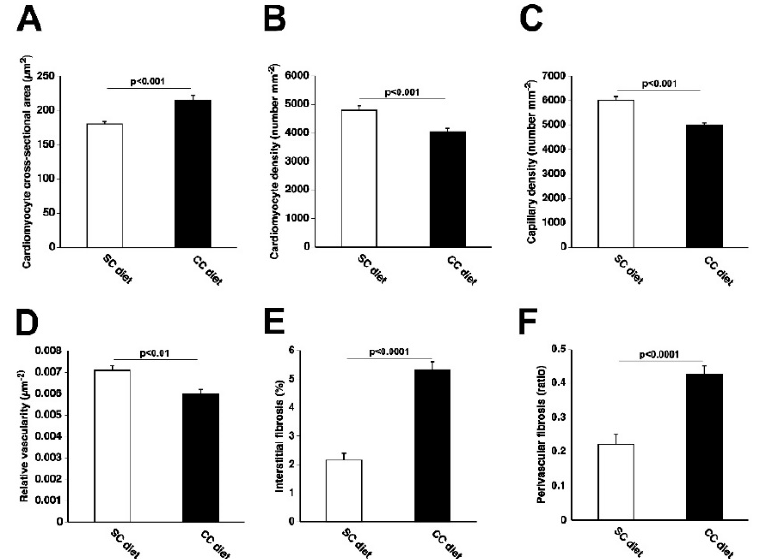
Figure 2. Body weight ( A ), glucose level ( B ), insulin ( C ), heart weight ( D ), tibia length ( E ), heart weight/tibia length ( F ), left ventricular weight ( G ), right ventricular weight ( H ), atrial weight ( I ), and lung weight ( J ) in C57BL/6 standard chow (SC) diet mice and in C57BL/6 coconut oil (CC) diet mice. CC diet was initiated at 12 weeks of age. Quantifications were performed at 38 weeks, 26 weeks after the start of the diet. SC diet mice and CC diet mice are indicated by open bars and closed bars, respectively. All data represent means ± SEM ( n = 15).